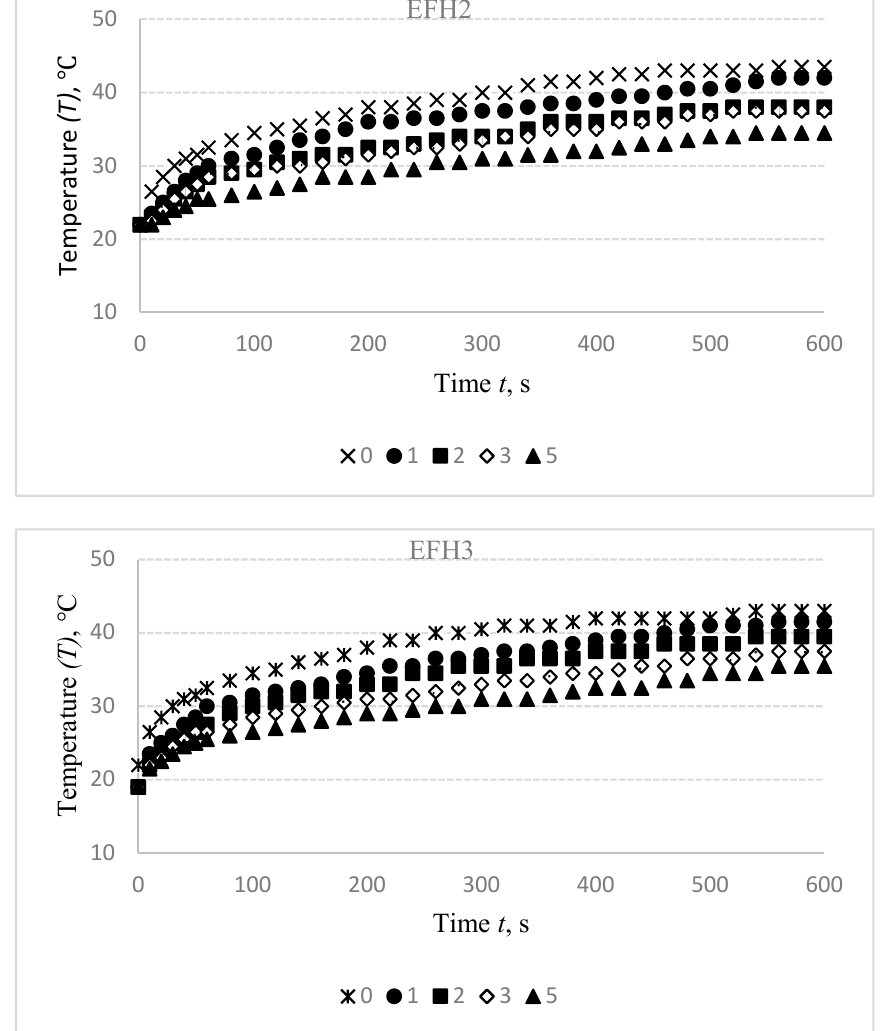
Figure 8. Temperature changes of EFL1, EFL2, EFL3, EFH1, EFH2, and EFH3 structured electro- conductive fabric during the 600 s period before washing and after different wash cycles: 1st, 2nd, 3rd, 5th.